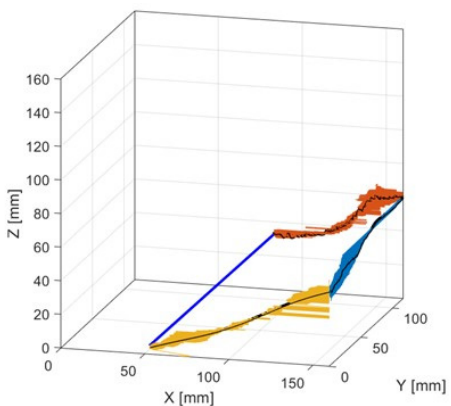
Figure 8. 3D image reconstruction identifying crack location from the processing of 3 perpendicular surface images.